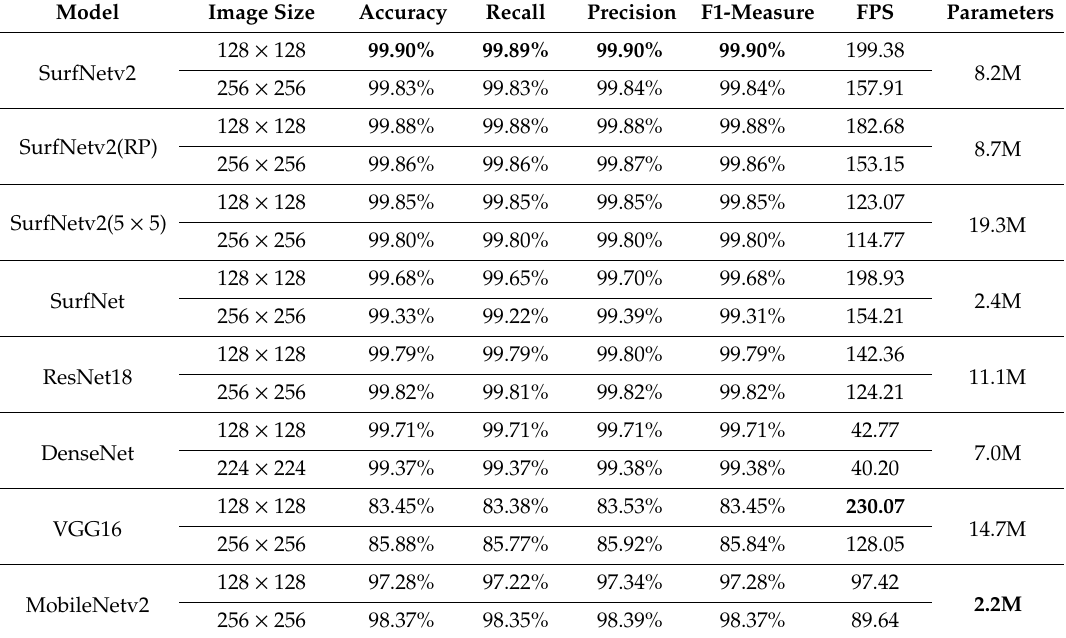
Table 6. Experiment results of the private CSB